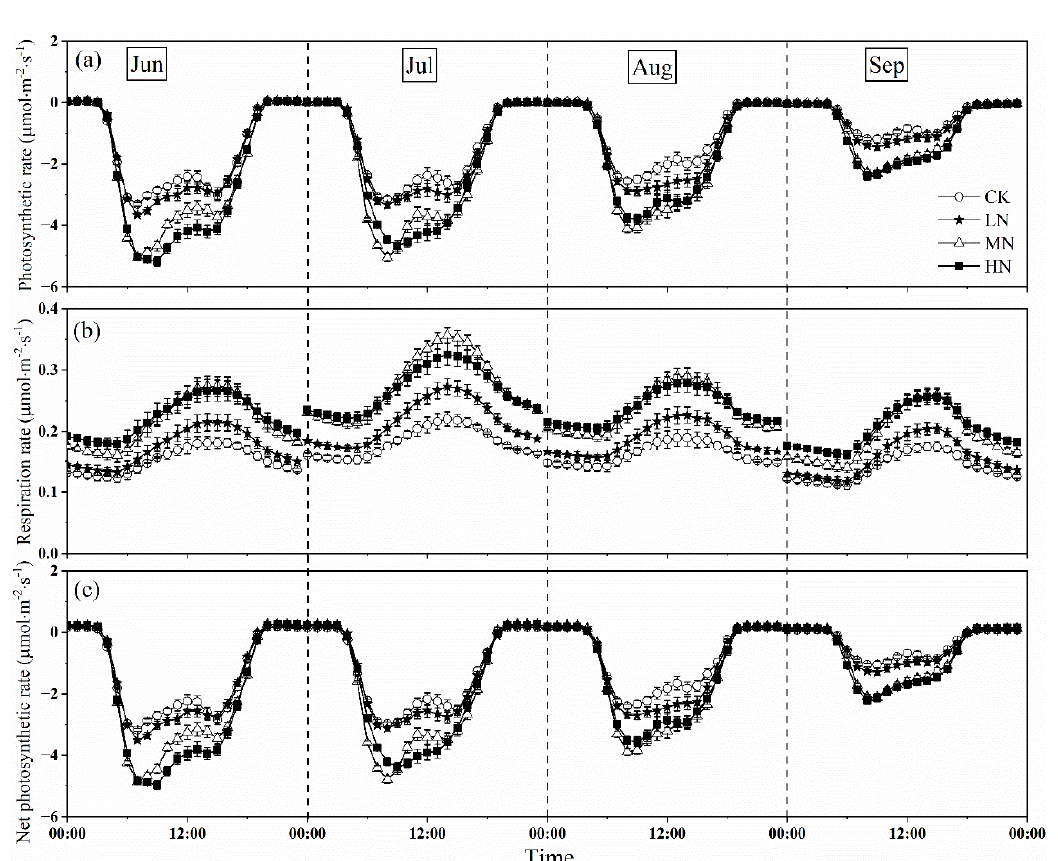
Figure 4. Monthly averaged diurnal variations in photosynthetic rate ( a ), respiration rate ( b ), and net photosynthetic rate ( c ) of Fraxinus mandshurica saplings after nitrogen addition and the control during the growing season (from 1 June to 30 September). CK, LN, MN and HN represent control (no nitrogen addition), low nitrogen addition (23 kgN · hm − 2 · a − 1 ), medium nitrogen addition (46 kgN · hm − 2 · a − 1 ) and high nitrogen addition (69 kgN · hm − 2 · a − 1 ), respectively.